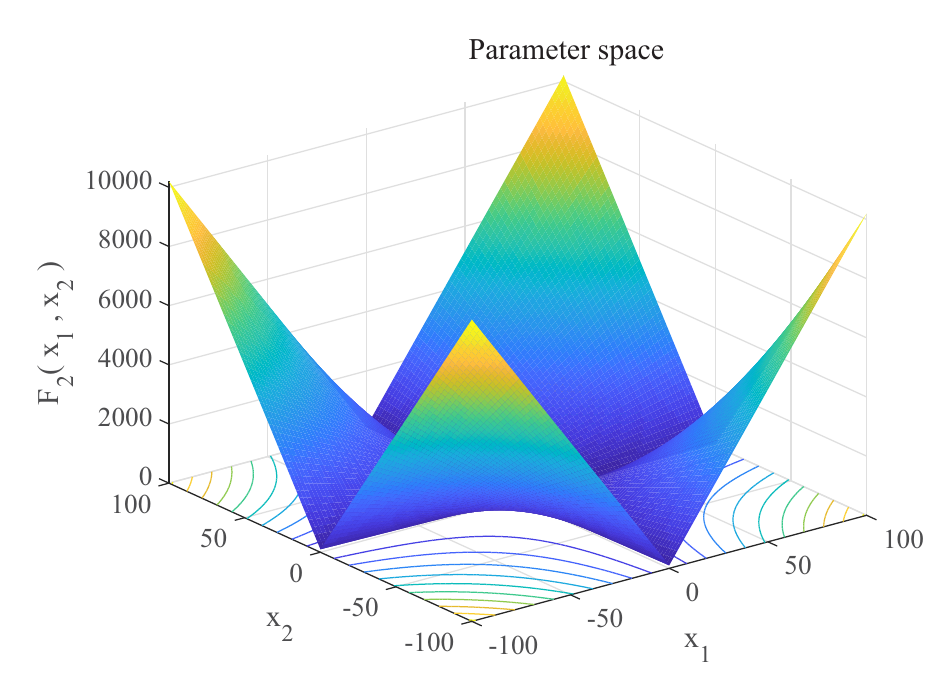
Fig 3. Three-dimensional graph of F 2 ( x ).